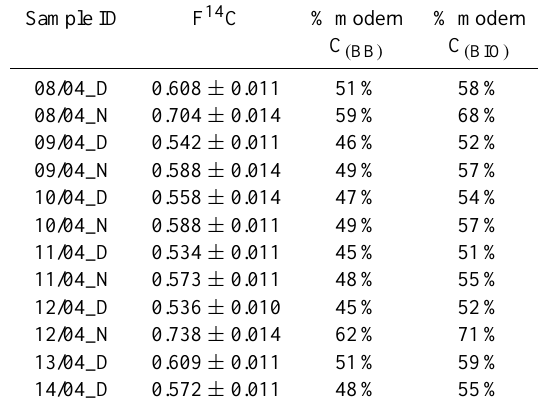
Table 6. Results of 14 C analysis. The activities of the samples taken directly from the measurements (F 14 C) are reported together with their experimental errors. The percentages of modern carbon with respect to the total were calculated taking into account two different scenarios: one in which we considered the modern carbon coming completely from biogenic aerosol (using fM(bio)=1.04) and the sec- ond one in which we considered the modern carbon derived entirely from biomass burning aerosol (using